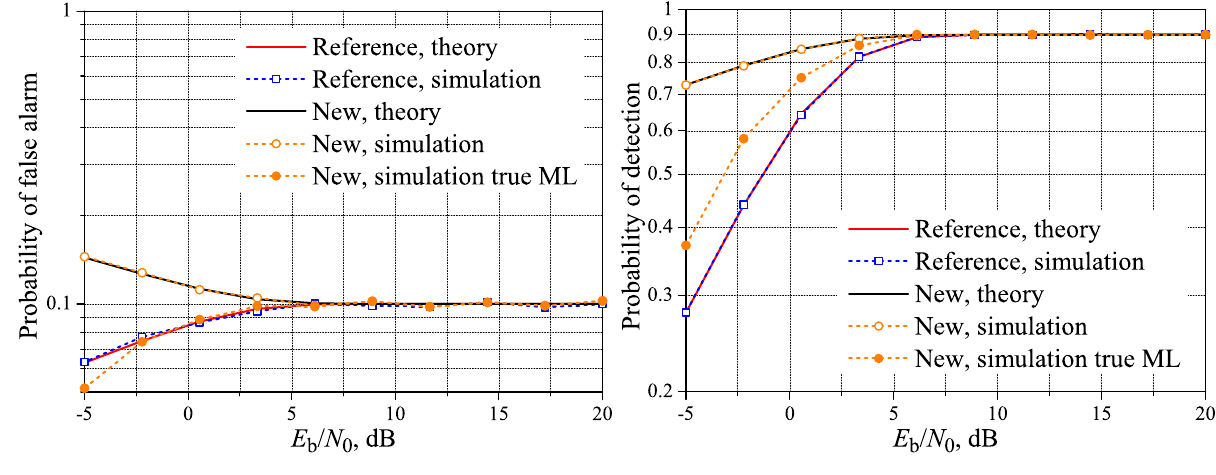
Figure 3. Spectrum sensing performance for the AWGN reporting channel. M = 5 and K = 1 ( top ); K = 3 ( middle ); and K = 5 ( bottom